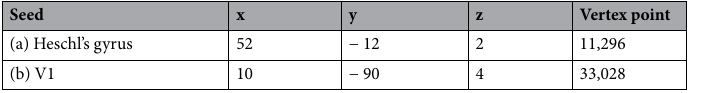
Table 1. Seed locations. Coordinates in MNI. Same vertex point for both hemispheres.